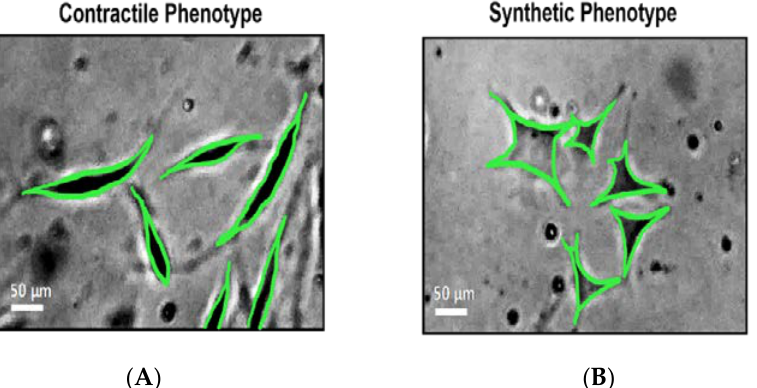
Figure 2. Phenotypic switch of human coronary artery smooth muscle cells (HCASMCs). Athero- sclerotic-mimic conditions (150 µM H 2 O 2 and 40 ng/ mL TNF- α) trigger a phenotypic shift from the contractile to synthetic form: ( A ) representative photograph of HCASMCs under control conditions, exhibiting a classical contractile, elongated shape; ( B ) representative photograph of HCASMCs